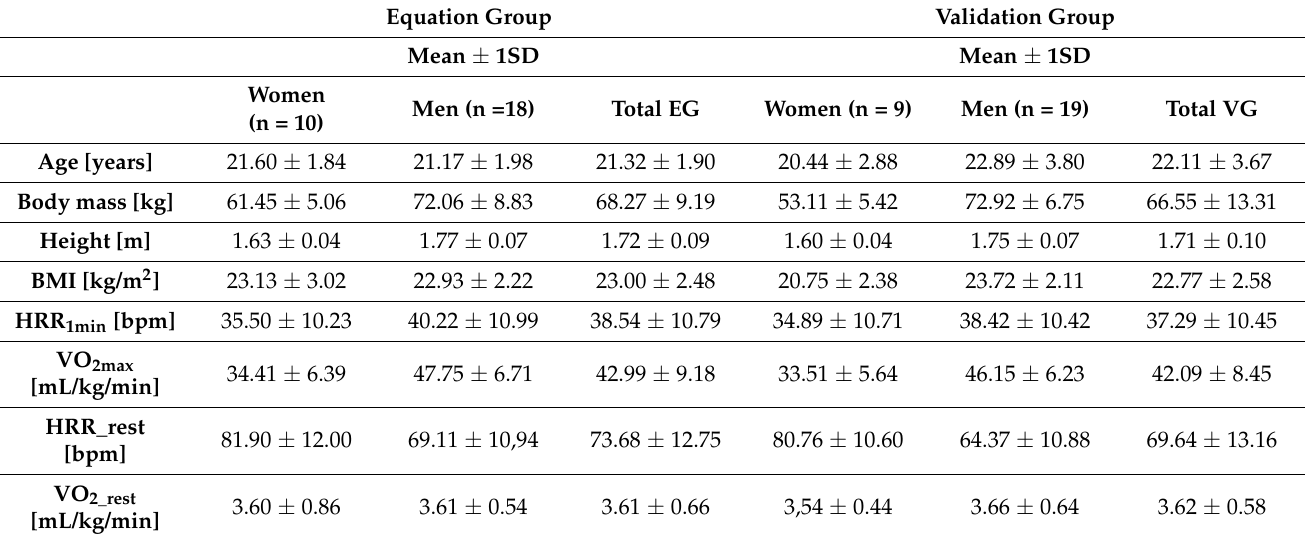
Table 1. Participants’ characteristics. Equation group—group for VO 2max prediction equation and Validation group—group for validation of prediction model. Equation Group Validation